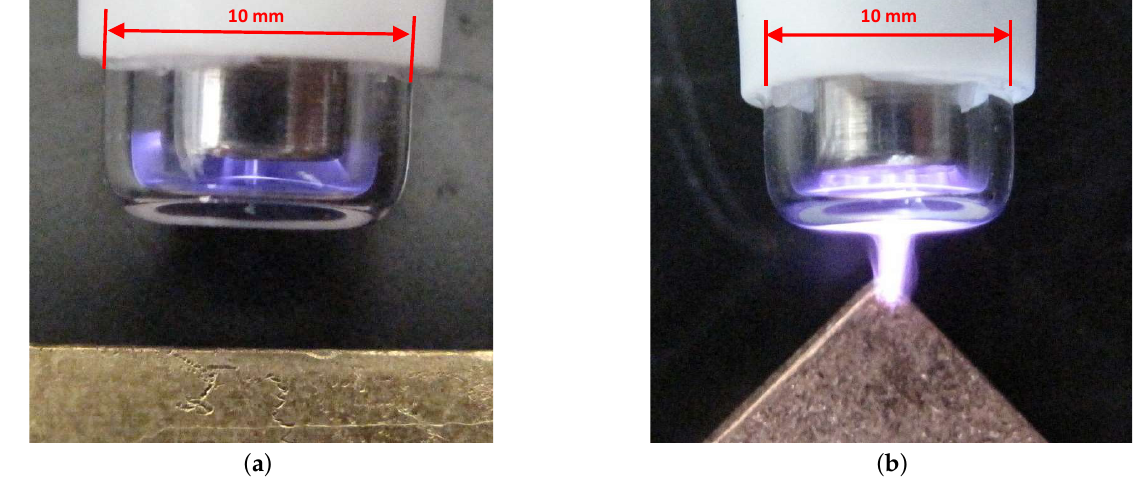
Figure 13. Influence of the distance and substrate shape on the structure of the discharge. ( a ) Too large distance—second DBD disappears, and ( b ) focusing of the micro-discharges at one spot on the sharp edge of the